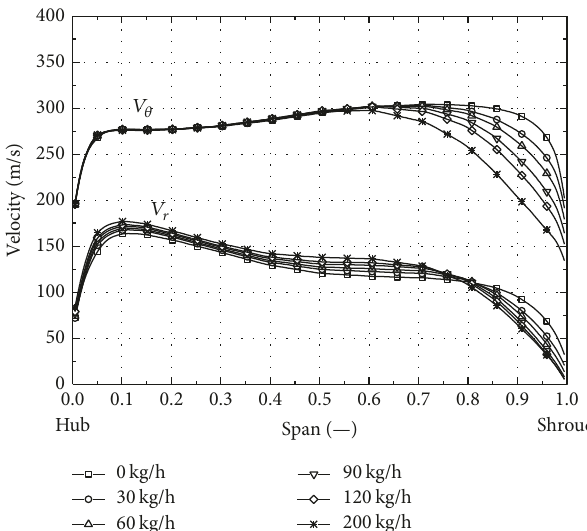
Figure 20: 𝑉 𝜃 and 𝑉 𝑟 with different steam injection at the diffuser inlet.